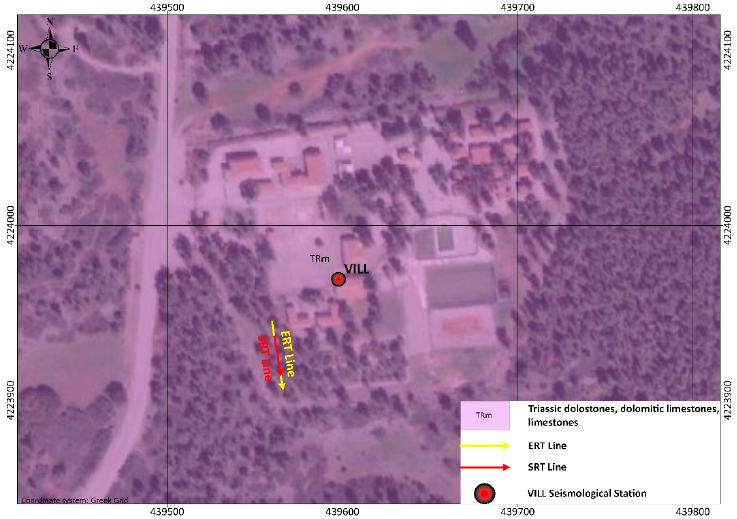
Figure 6. Location of the seismological station VILL and the geophysical measurements along with the geology of the area.